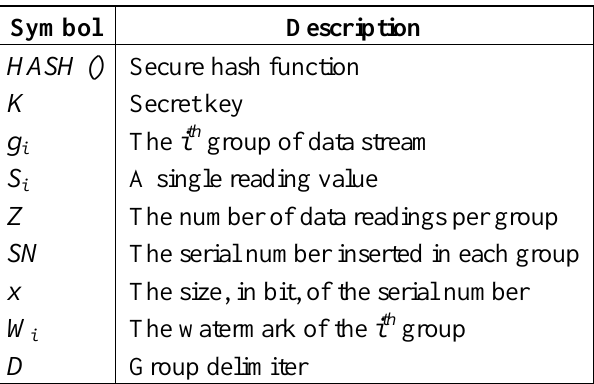
Table 1. Notations and